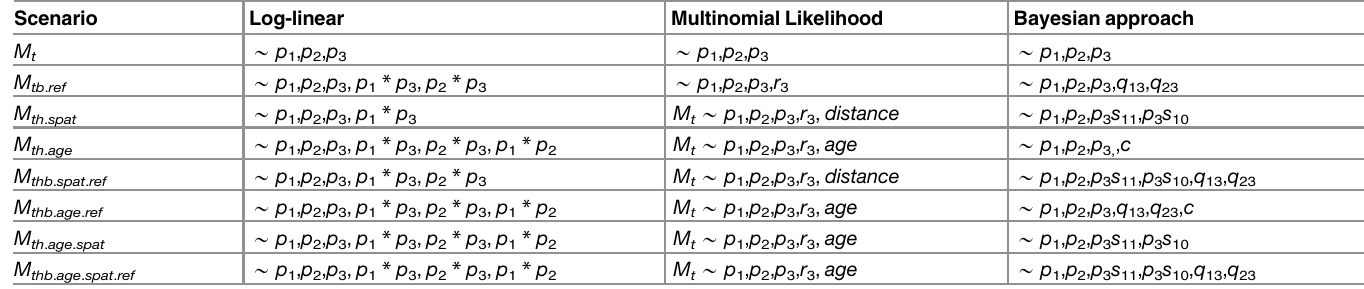
Table 3. Models with assumptions about the underlying dependency structure. For log-linear models a selection was made out of all hierarchical mod- els. For the multinomial models a selection was made out of all possible models (including models with probabilities conditional on covariates, mixtures and previous detections). p 1 = p(sentinel), p 2 = p(hospital), p 3 = p(NRC), distance in meters, age in days, q = referrals, r = (re)detection probability conditional on previous detection,